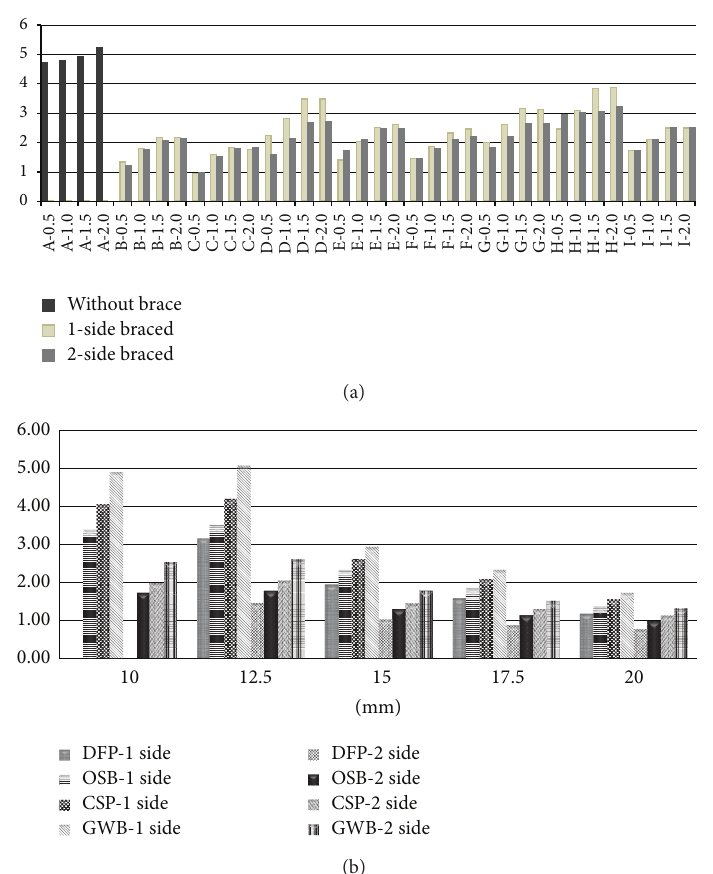
Figure 15: Maximum lateral drift ratio (%). (a) Braced walls. (b) Sheeting walls with variable of the